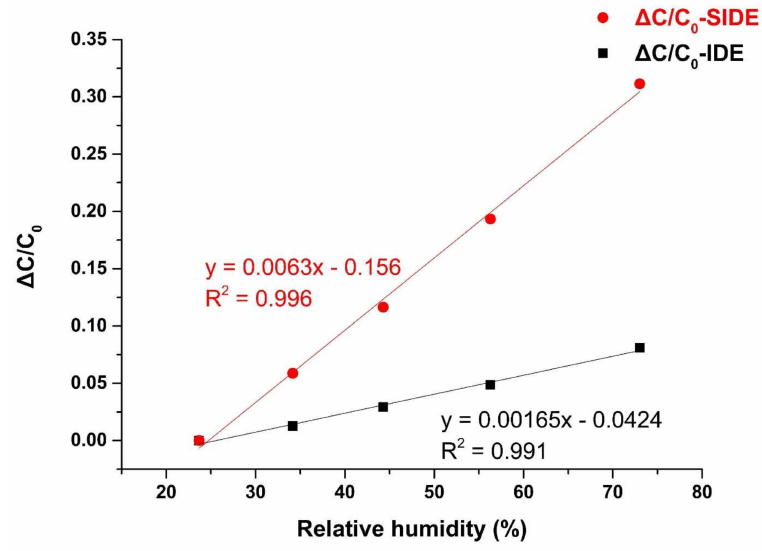
Figure 8. Experimental measurement of sensitivity of SIDE and IDE humidity